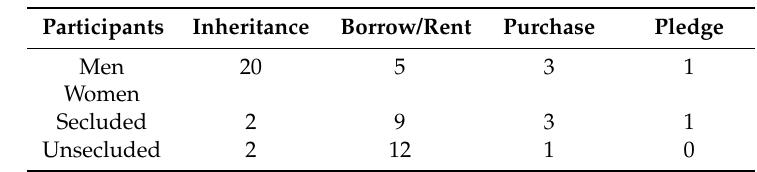
Table 1. Forms of land access recorded in interviews with 24 women and 20 men in the two case study communities of Bemun and